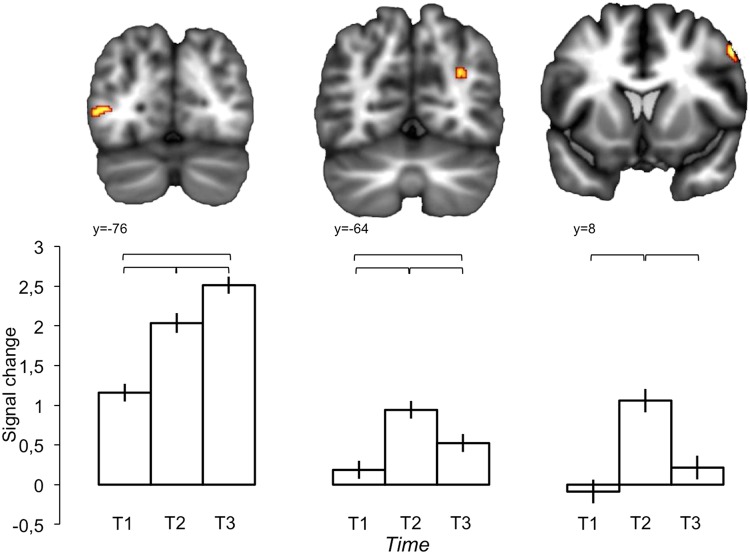
fMRI main effect of Time in (from left to right) left middle occipital gyrus, right posterior intrapareital sulcus, and right precentral gyrus.Brackets indicate significant post-hoc comparisons.